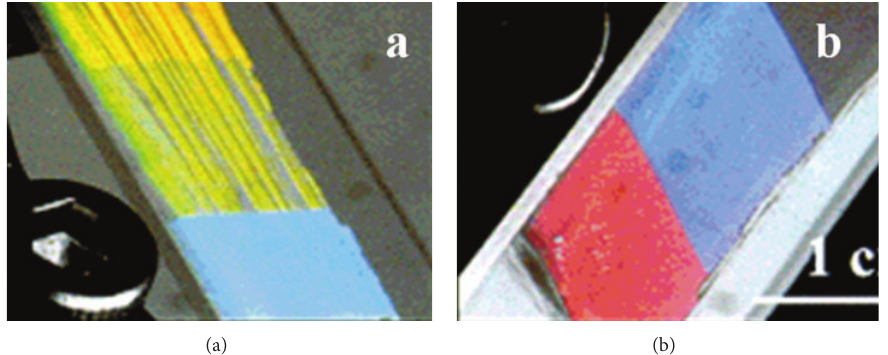
Figure 6: Reflected colors of colloidal dispersions registered at different angles [36].